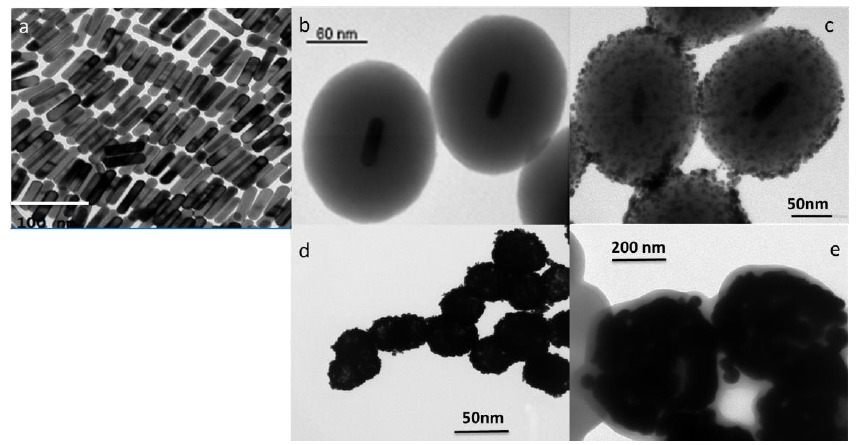
Figure 1. TEM images: AuNR@CTAB ( a ); AuNR@SiO 2 ( b ); AuNR@SiO 2 @seed ( c ); AuNR@SiO 2 @Au